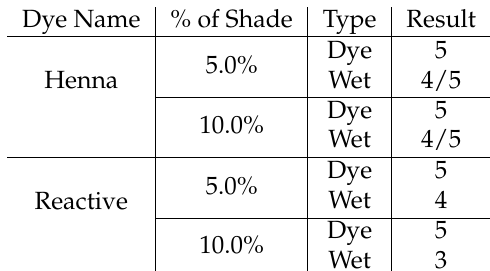
Table 3. Effect of color fastness to